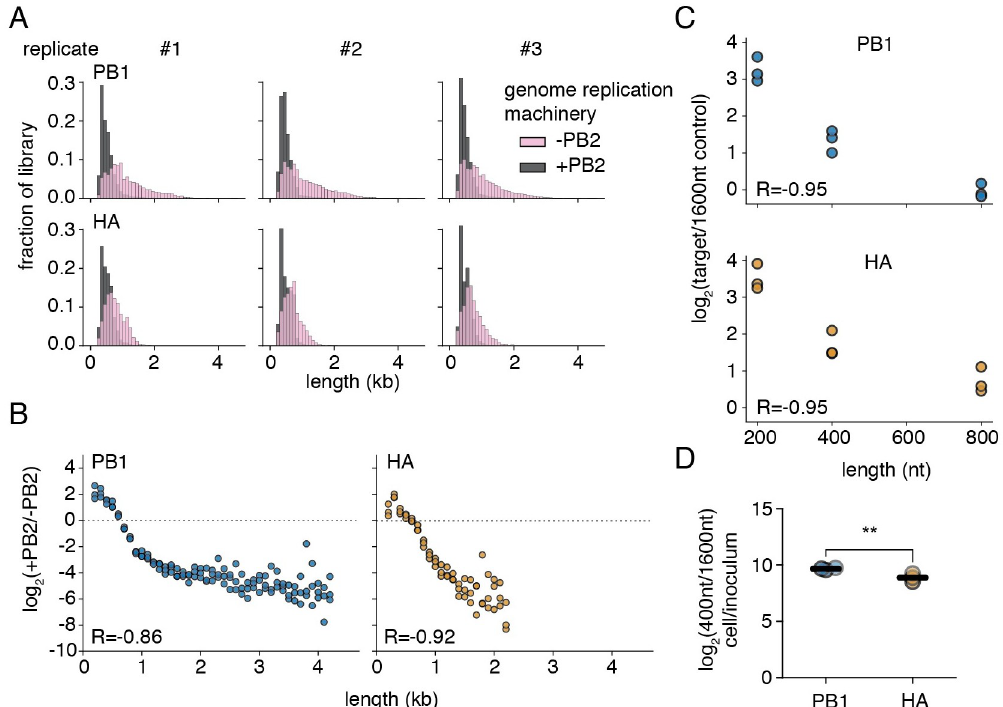
Fig 2. Segment length and genome replication efficiency are inversely correlated. (A) Size distributions of libraries in transfections with (+PB2) and without (-PB2) the full viral genome replication machinery 24 hours post-transfection in 293t cells. Polymerase length biases are shown in S1 Fig (B) Smaller species are enriched during genome replication. The fraction of variants falling within each 100nt bin was compared between replication-competent (+PB2), and -incompetent (-PB2) selections. Points above the dotted line represent sizes in each individual library which were enriched in the +PB2 dataset. Points were only shown if represented in all three libraries under both conditions R is the Spearman correlation coefficient. n = 3. (C) qPCR supports the conclusion that genome replication is inversely correlated with length. Vectors encoding variants of four seperate lengths (200, 400, 800, and 1600nt) were transfected into 293t cells with and without the full viral genome replication machinery and analyzed by qPCR 24 hours post transfection. The fraction of each variant was calculated relative to the longest variant (1600nt), and this value compared between replication-competent and -incompetent datasets to determine the relative enrichment attributable to genome replication. R is the Spearman correlation coefficient. n = 3. Validation of qPCR in S2 Fig. (D) Shorter defective viral genomes are enriched during genome replication in viral infection. A549 cells were infected with mixed populations consisting of 400 and 1600nt variants of either HA or PB1 and a complementing wild-type strain at a combined MOI of 25, as measured in genomic equivalents by qPCR. Cells were then washed to remove any additional virus at 2 hours post infection, and, at 14 hours post infection supernatant was removed and cellular RNA harvested. The initial ratio of these two variants was measured in the viral inoculum by qPCR, and compared with the ratio in the cellular fraction. Both PB1 and HA 400nt were enriched over 1600nt by one-tailed t-test, Benjamini- Hochberg corrected FDR < 0.05. The effect was stronger for PB1 than HA, two-tailed t-test, p < 0.05. Each point is a single replicate, lines are the mean. n = 3. Validation that second rounds of infection are excluded is in S3